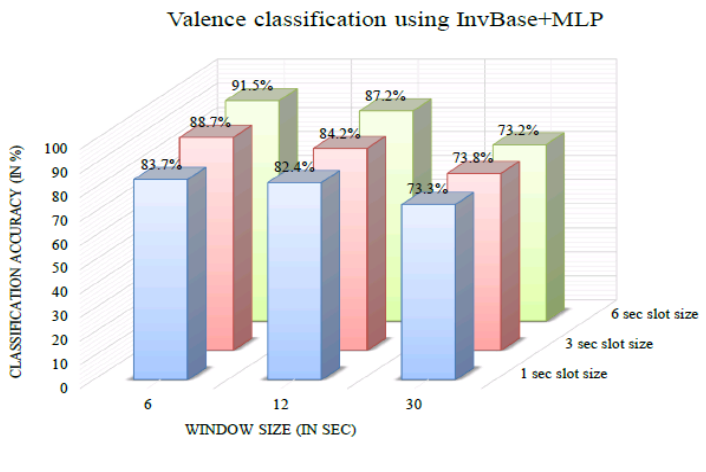
Figure 9. Valence classification accuracy of InvBase+MLP method for various window sizes.